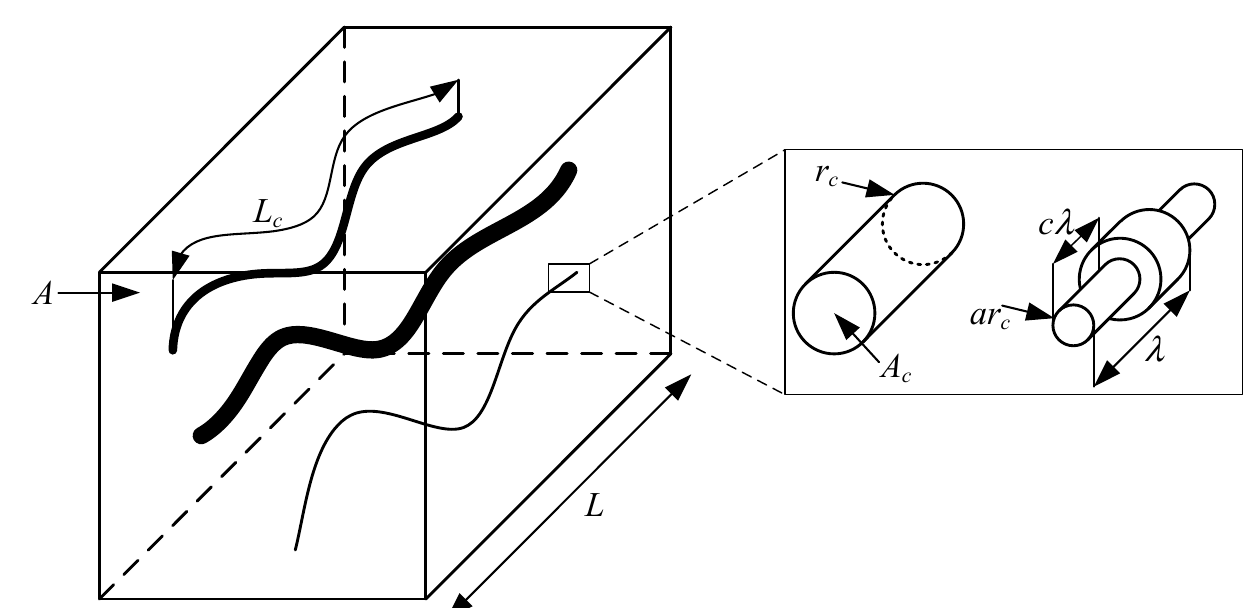
Figure 1. The bundle of capillary tubes (bold curves) model. The inset to the right shows the two representations of modelled capillaries having the (i) constant (left) and (ii) alternating (right) radius. In the alternating capillary radius model, the pore throat is modelled by a reduced radius ar c , while the pore throat length is defined by c λ , where λ is the pattern length, which is described in more detail below [35].